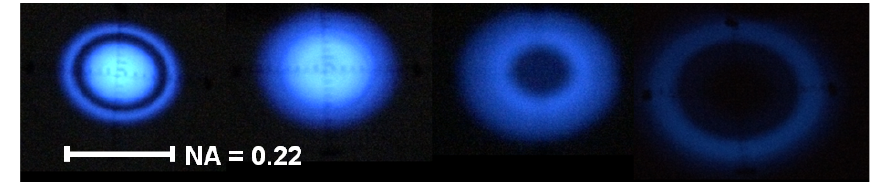
Figure 3. Pictures of the beam at the exit of a 1mm diameter fiber illuminated with a 468nm LED at different incident angles. The beam is observed on a screen located at a distance of 20mm after the fiber exit. The scale shows a numerical aperture (NA) of